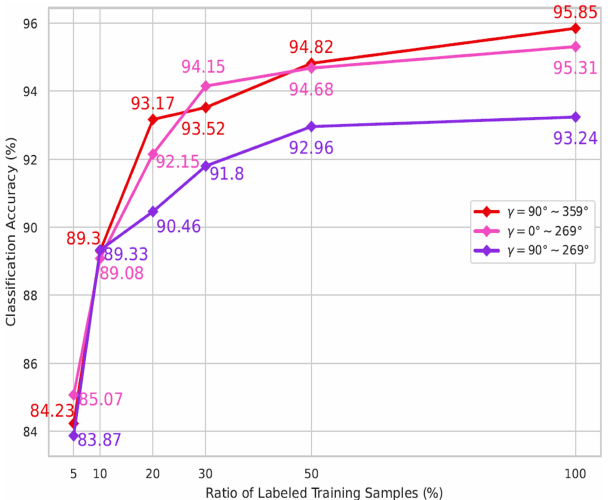
Figure 12. Classification accuracy of CLISAR-Net when different ranges of the azimuth angle are included in the training set of the combined deformation